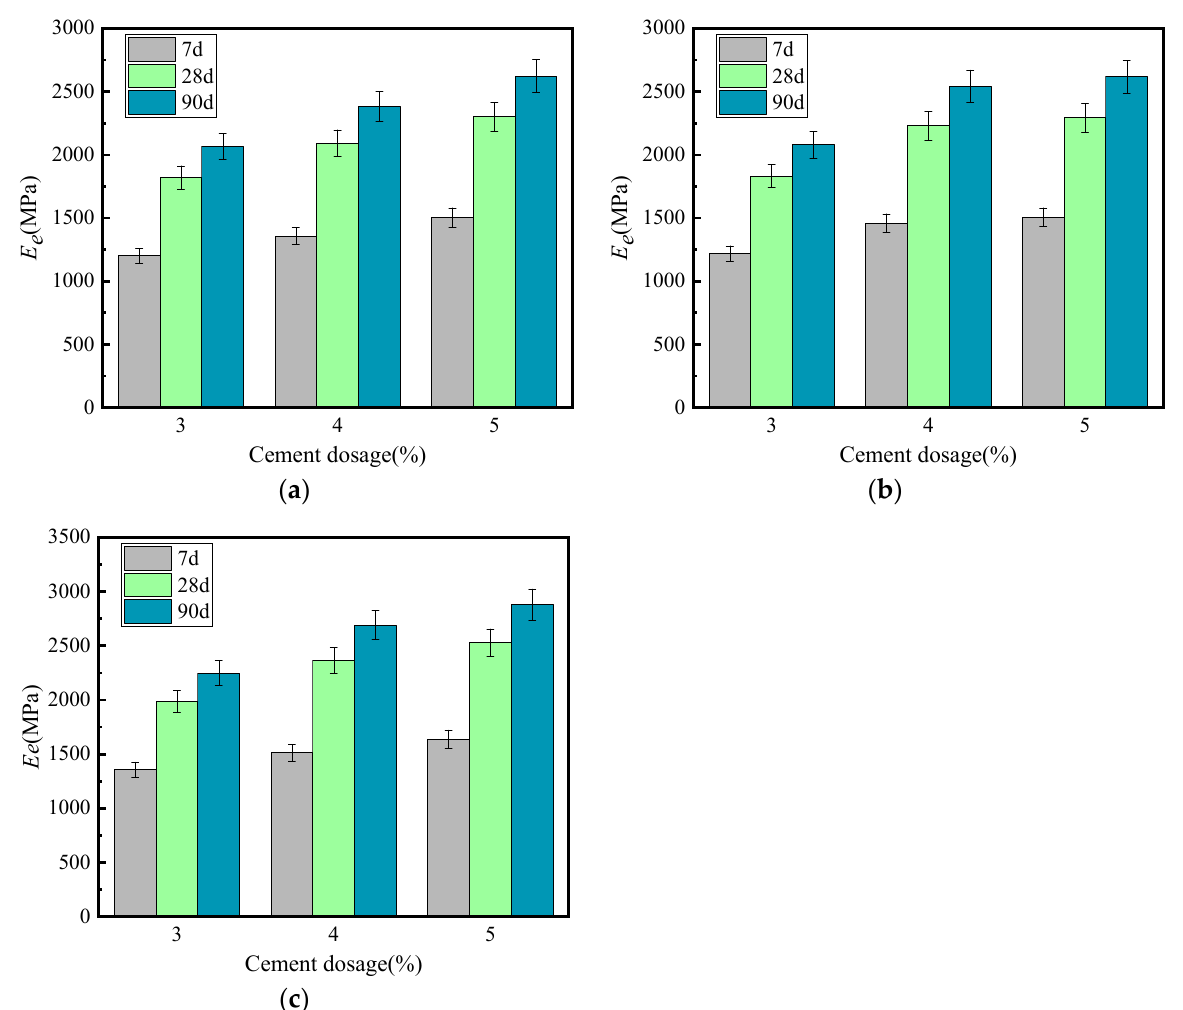
Figure 7. Growth law of resilient modulus under different cement dosage. ( a ) GF1, ( b ) GF2, ( c ) VGM-30.